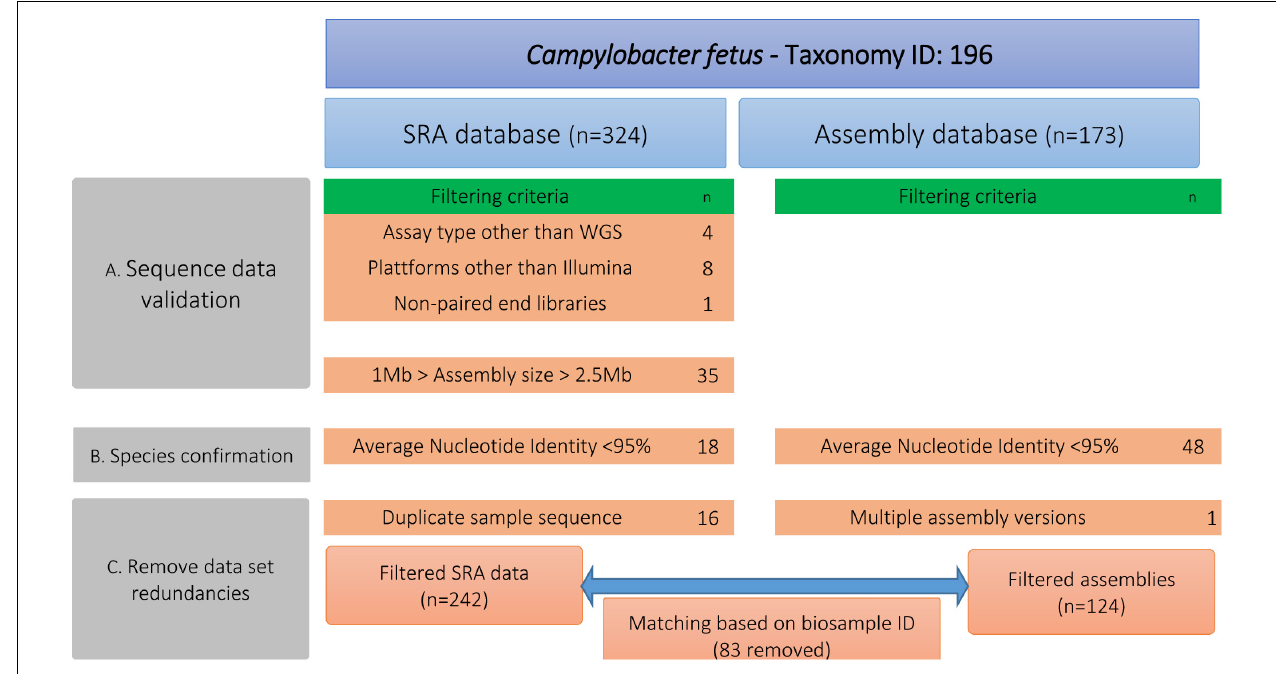
FIGURE 1 | Different steps for filtering the publicly available genomic data of Campylobacter fetus including number of filtered data sets. Step A performed quality assurance via removing genomes that deviated from the average C. fetus genome size ( ∼ 1.8 Mbp ± 25%). Step B measured pairwise ANI and excluded genomes with < 95% accordance. Step C removed data redundancies by matching raw sequence data and genome assemblies based on the